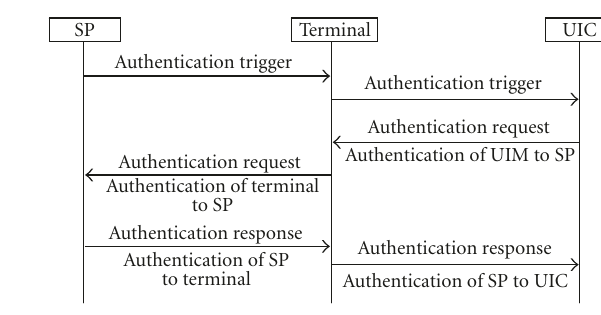
Figure 1: Function flow of the smartcard profile. Figure 2: Overview of the proposed